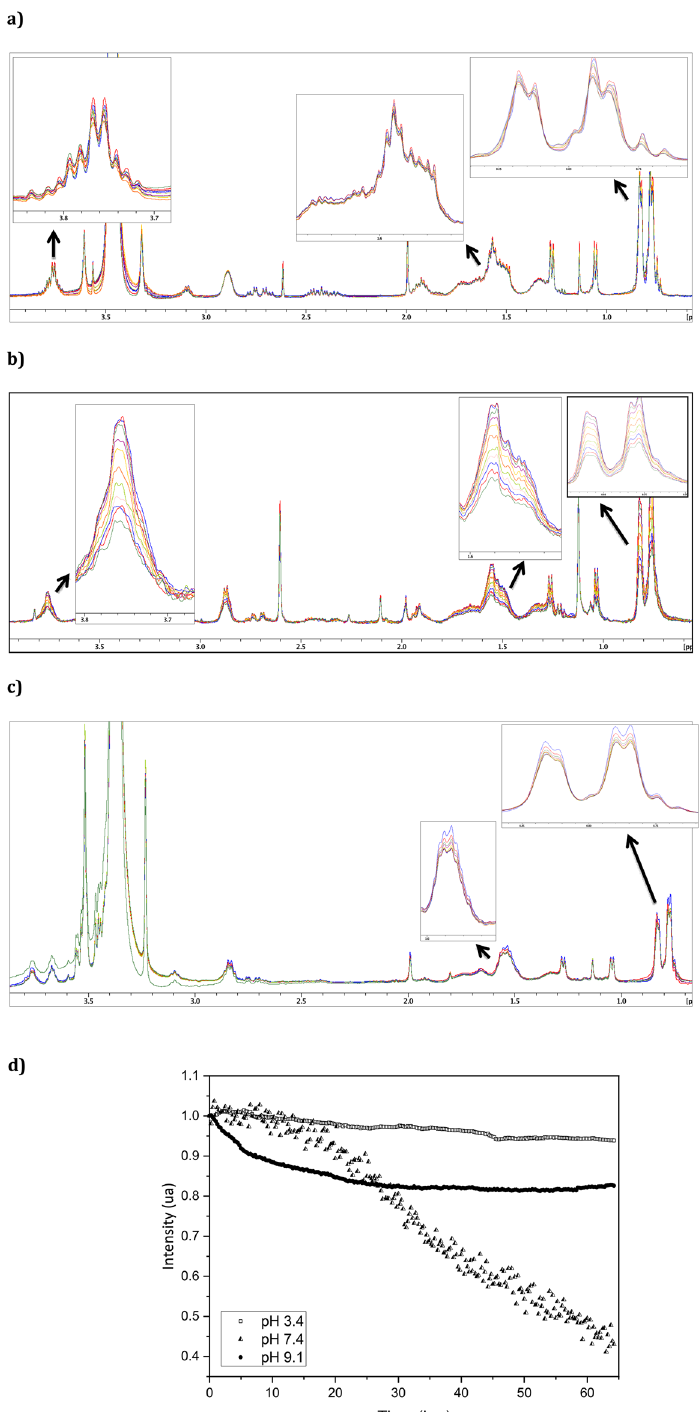
Figure 2. Evolvement of the intensity of the ERα17p aliphatic proton signals as a function of time, by 1D 1 H- NMR (500 MHz). Aliphatic proton signals of highest intensity (0.80, 0.90, 1.50 and 3.60 ppm) are used to follow aggregation. Each experiment (8 scans/15 min.: 258 points over 65 h) is performed at ( a ) pH 3.4 (0.2 M glycine HCl in water), ( b ) 7.4 (0.2 M KH 2 PO 4 /0.2 M K 2 HPO 4 in water) and ( c ) 9.1 (0.2 M glycine NaOH in water), at 298 K and with peptide samples of 100 μM in water. ( d ) Evolvement of the intensity of the proton signals as a function of time, at pH 3.4, 7.4 and